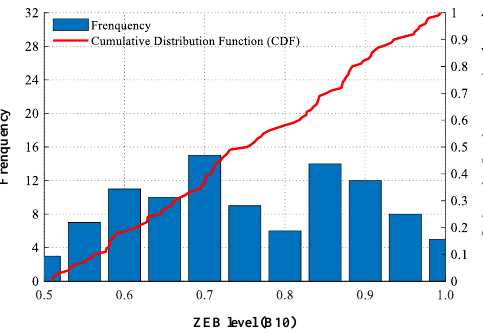
Fig. 9. Distribution of ZEB level for 10 th